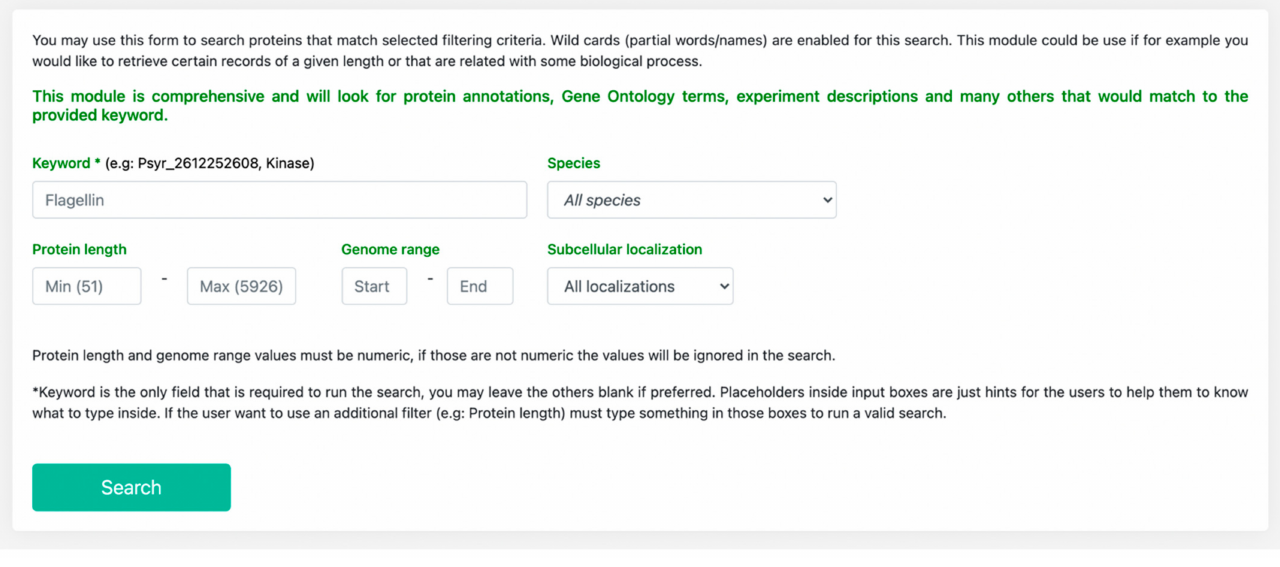
Figure 3. Advanced search module of alfaNET displaying the default parameters.